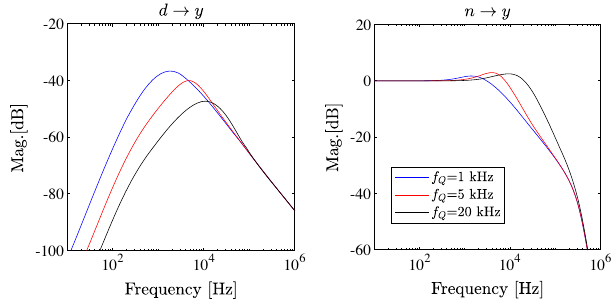
FIG. 17. Upper boundary for the singular values of the closed- loop transfer function from d and n to y in terms of different f Q .